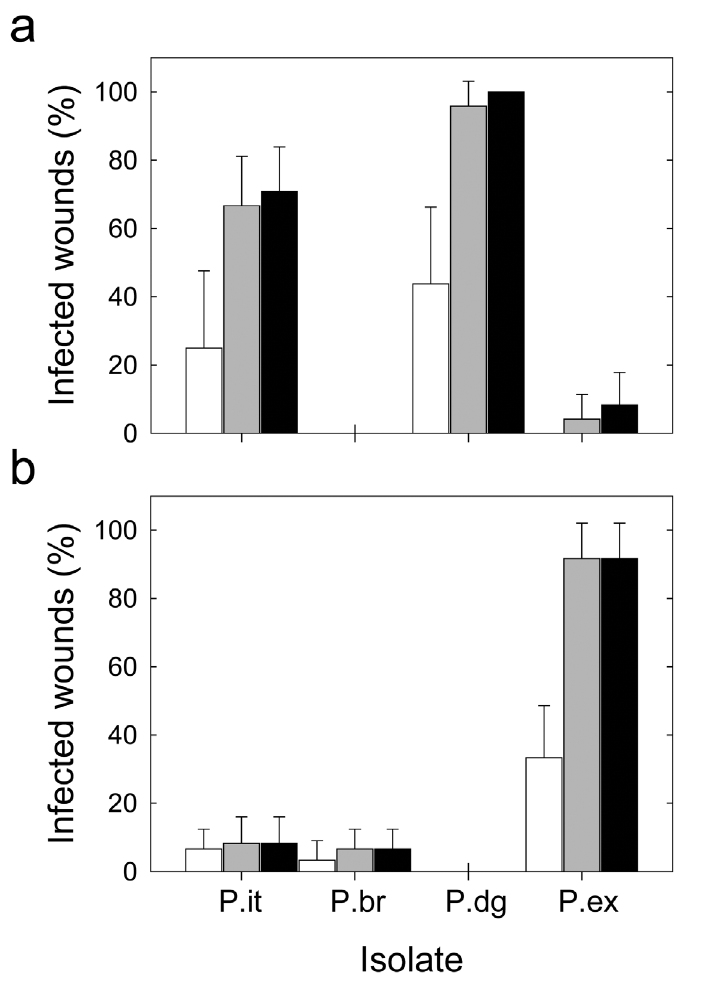
Figure 2. Fungal infection on fruits. Conidia of Penicillium italicum PHI-1, P. digitatum PHI-26, P. brevicompactum PHI-8, and P. expansum PHI-65 were inoculated onto orange (a) or apple (b) fruits, and kept at 20ºC and 90% RH. Graphs show the percentage of infected wounds ± SD recorded every day post inoculation (dpi) at 3 dpi (white bars), 5 dpi (grey bars) and 7 dpi (black bars). Abbreviations: P.it: P. italicum PHI-1; P.dg: P. digitatum PHI-26; P.br: P. brevi- compactum PHI-8; P.ex: P. expansum